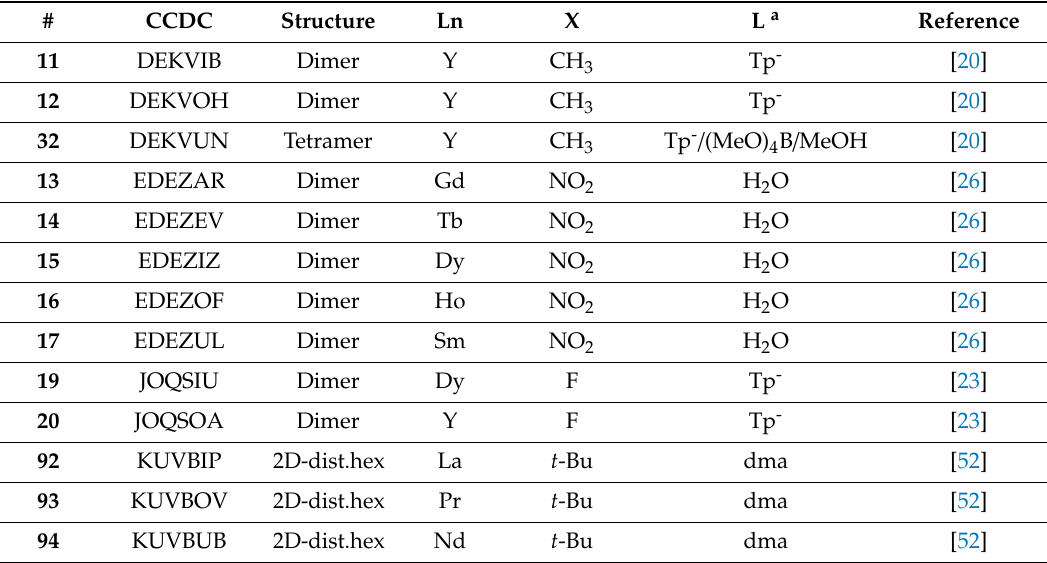
Table 12. Structurally characterized Ln compounds with other anilato-type ligands.